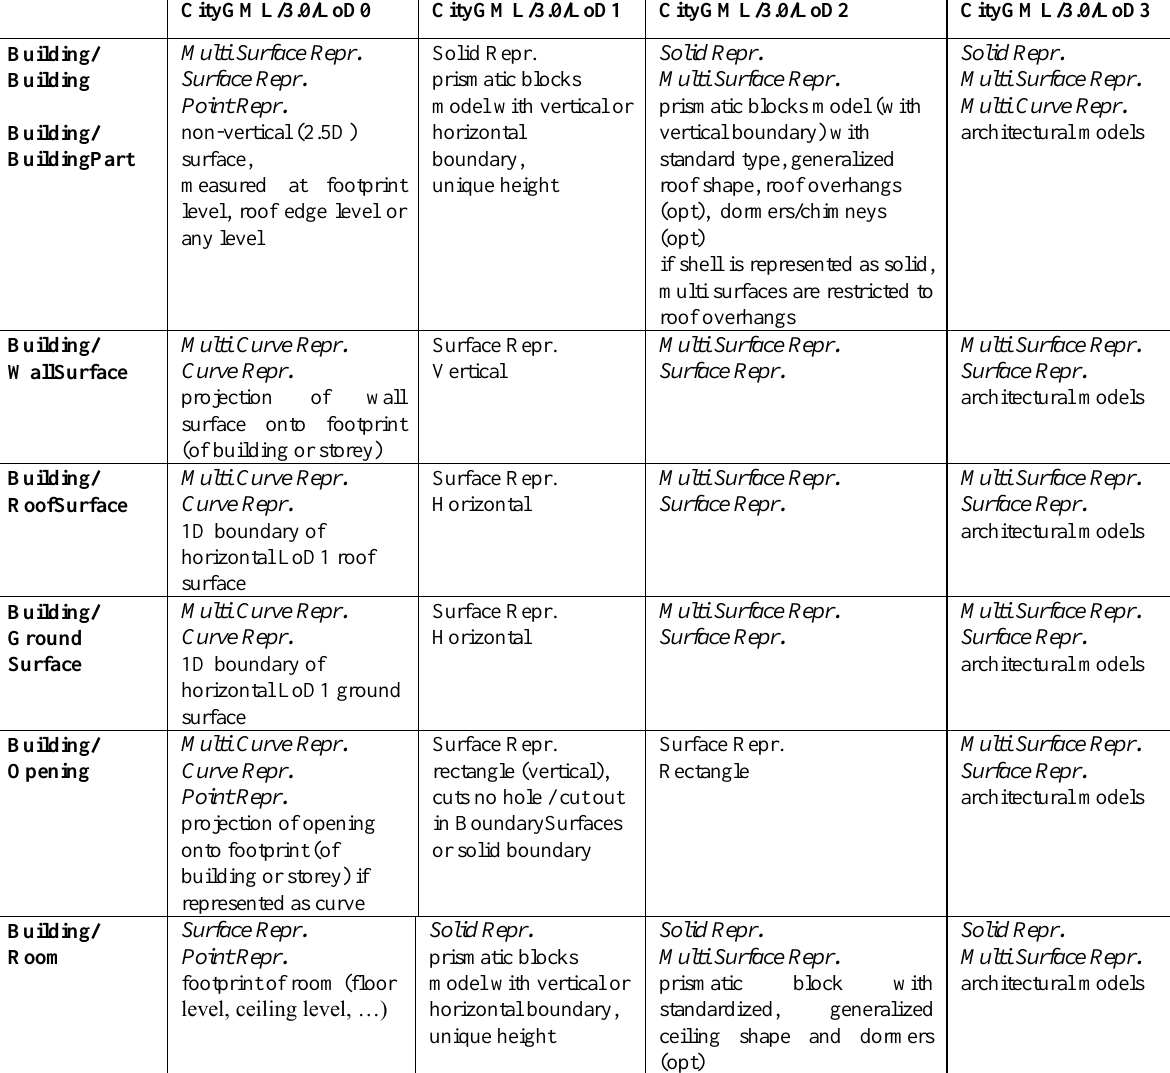
Table 2. Proposal for profiles supporting interoperability (building module). For abbreviations and explanations, see the remarks in the text. Geometry types in italics are used mutually exclusively in one profile. The contextIdentifiers of the profiles are a combination of a level name in the first row and a module/feature type name in the first